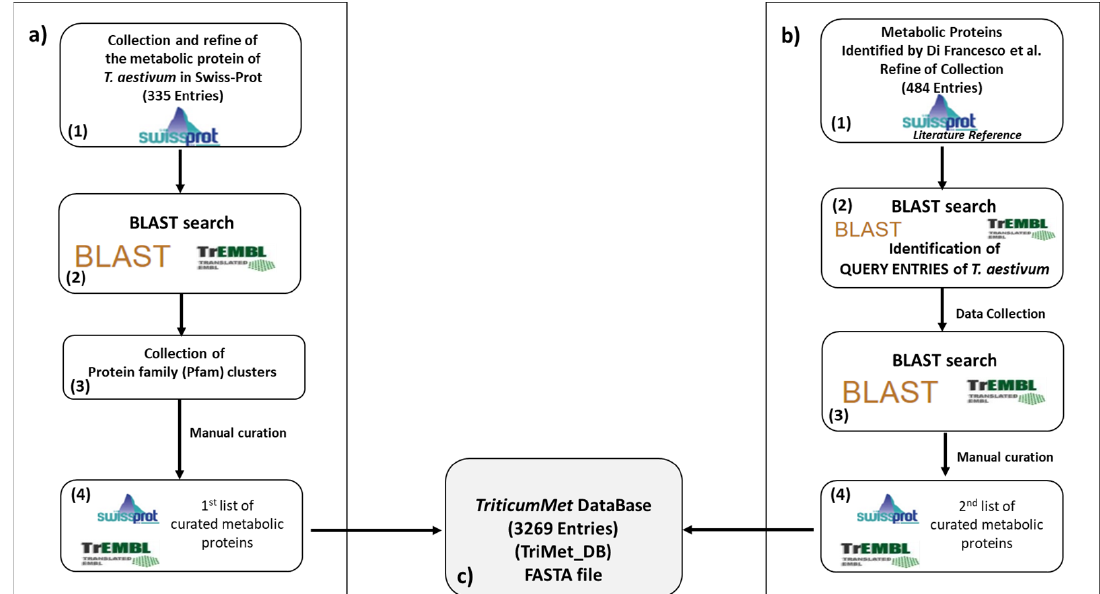
Figure 1. Scheme of the approach carried out to compile the manually curated TriMet Database. ( a ) Scheme of the approach that used as a starting point the complete list of Triticum aestivum entries reported in the Swiss-Prot section of the UniProt database; ( b ) scheme of the approach that used as a starting point the list of metabolic wheat proteins identified, by means of a MS-shotgun approach, in the recent work of Di Francesco et al. (Di Francesco et al., 2019) [31] ( c ) Number of sequence entries included in the TriMet_DB FASTA file.